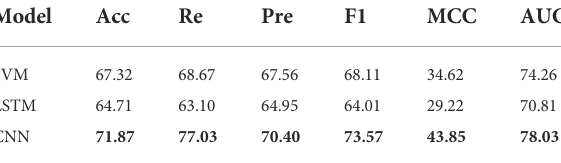
TABLE 4 Performance of different model architectures on the independent test data.